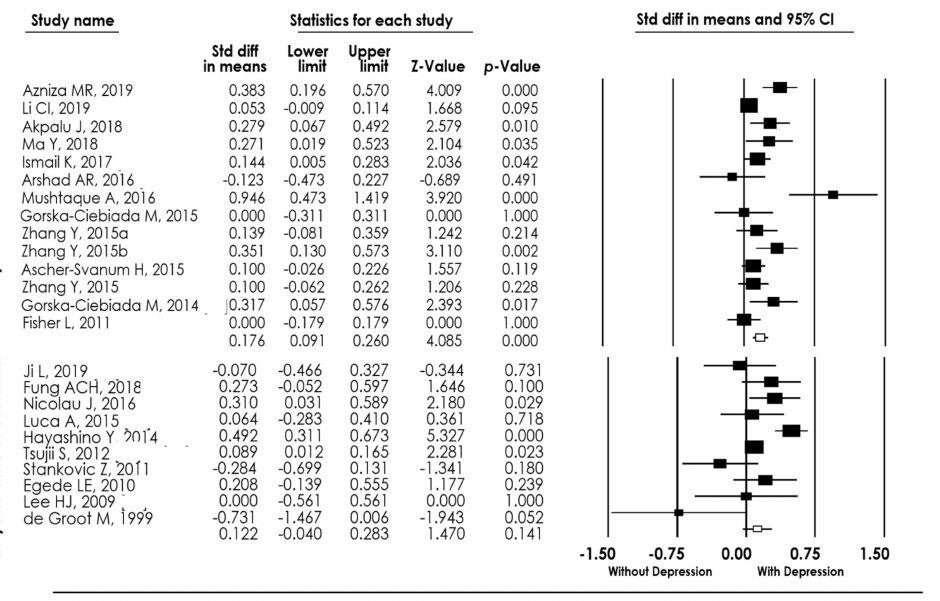
Figure 4. Forest plot of the meta-analysis for HbA1c levels in individuals with type 2 diabetes mellitus (T2DM) and with/without depression regarding the duration of diabetes evolution [4,11,14–19,21,22,24–28,28,29,29–33,36,37,40,43].